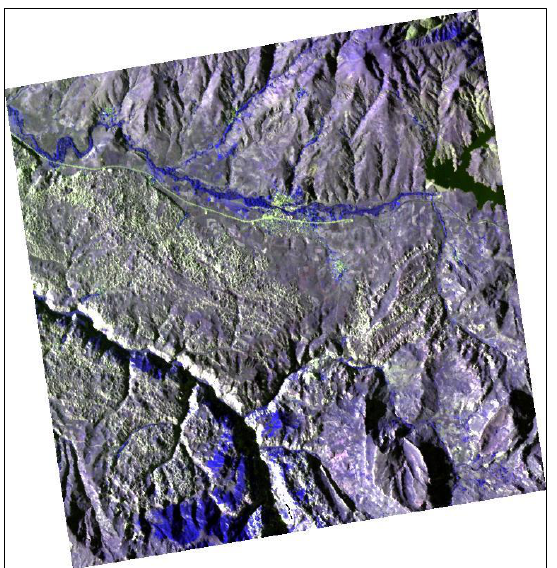
Figure 3. CHRIS Proba image of the study area (R: Band 9, G: Band 4, B: Band